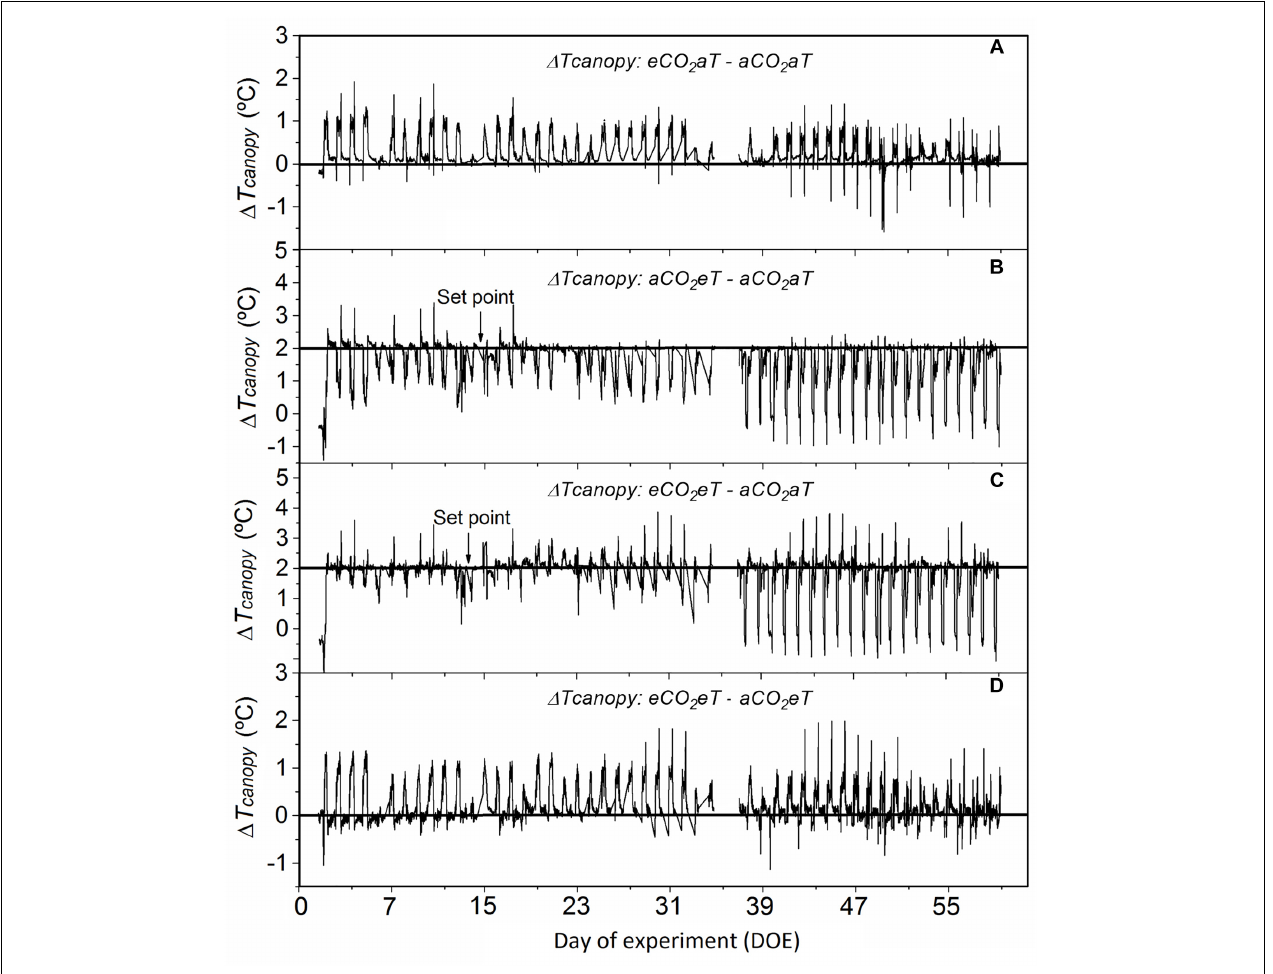
FIGURE 3 | Difference in canopy temperature ( (cid:49) T canopy ) of Stylosanthes capitata during the experiment. (A) (cid:49) T canopy between eCO 2 aT – aCO 2 aT plots. (B) (cid:49) T canopy between aCO 2 eT – aCO 2 aT plots. (C) (cid:49) T canopy between eCO 2 eT – aCO 2 aT plots. (D) (cid:49) T canopy between eCO 2 eT – aCO 2 eT plots. T canopy was recorded every 15 min by Apogee infrared radiometers. Arrows indicate the point 2 ◦ C above the ambient canopy temperature that was set in warmed treatments. The missing values between days 35 and 37 after treatment are due to a dead datalogger battery on these days. Treatments: aCO 2 aT (ambient [CO 2 ] and ambient temperature), eCO 2 aT (elevated [CO 2 ] and ambient temperature), aCO 2 eT (ambient [CO 2 ] and elevated temperature) and eCO 2 eT (elevated [CO 2 ] and elevated